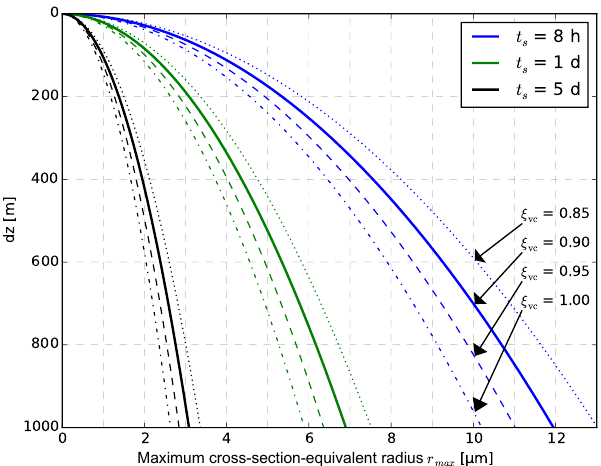
Figure 1. Maximum cross-section-equivalent radius r max of dust particles as a function of distance d z from the SAL top after dif- ferent settling time periods t s assuming different shape-dependent conversion factors ξ vc . ξ vc = 1 corresponds to spherical